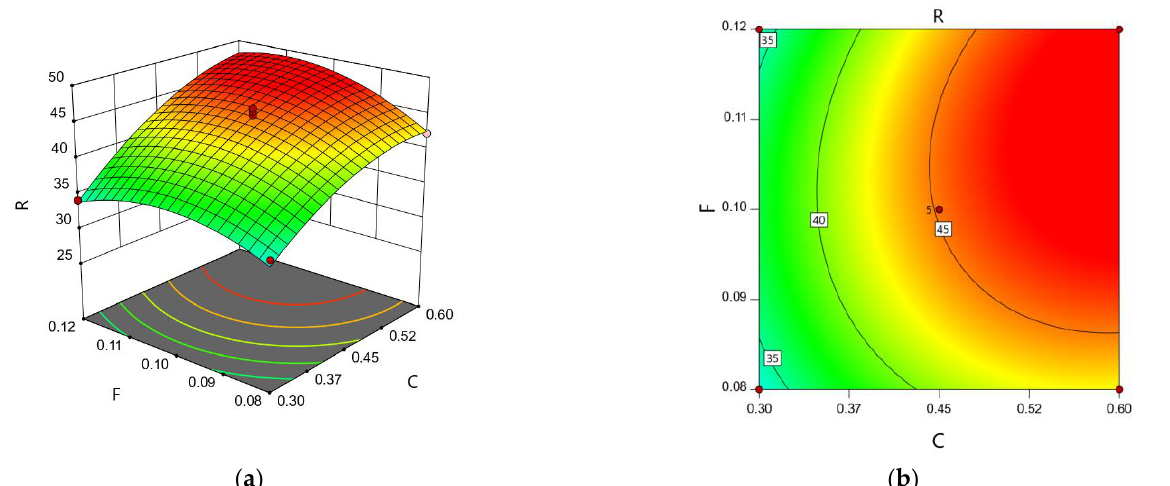
Figure 11. Influence of JKR surface energy and rolling friction coefficient on angle of repose surface diagram ( a ) and contour diagram ( b ).